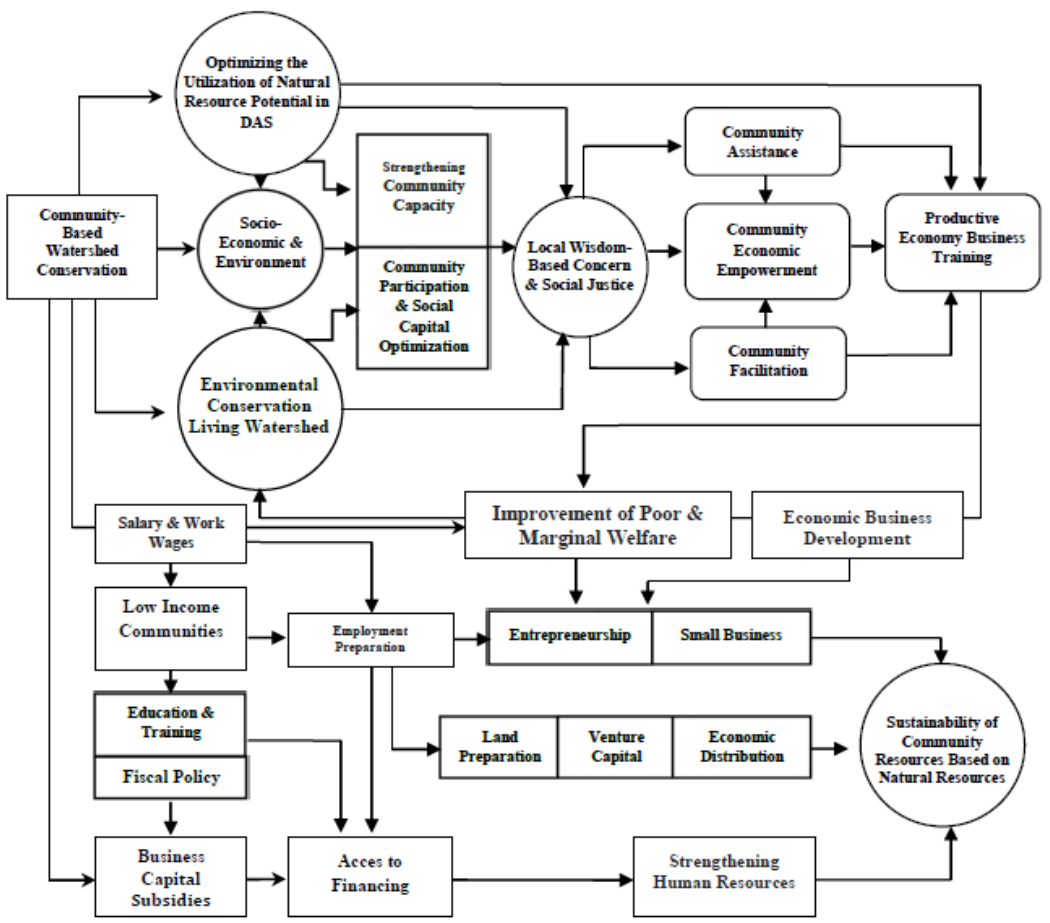
Figure 13. Community Economic Empowerment Based on Management of Settlements and Watershed